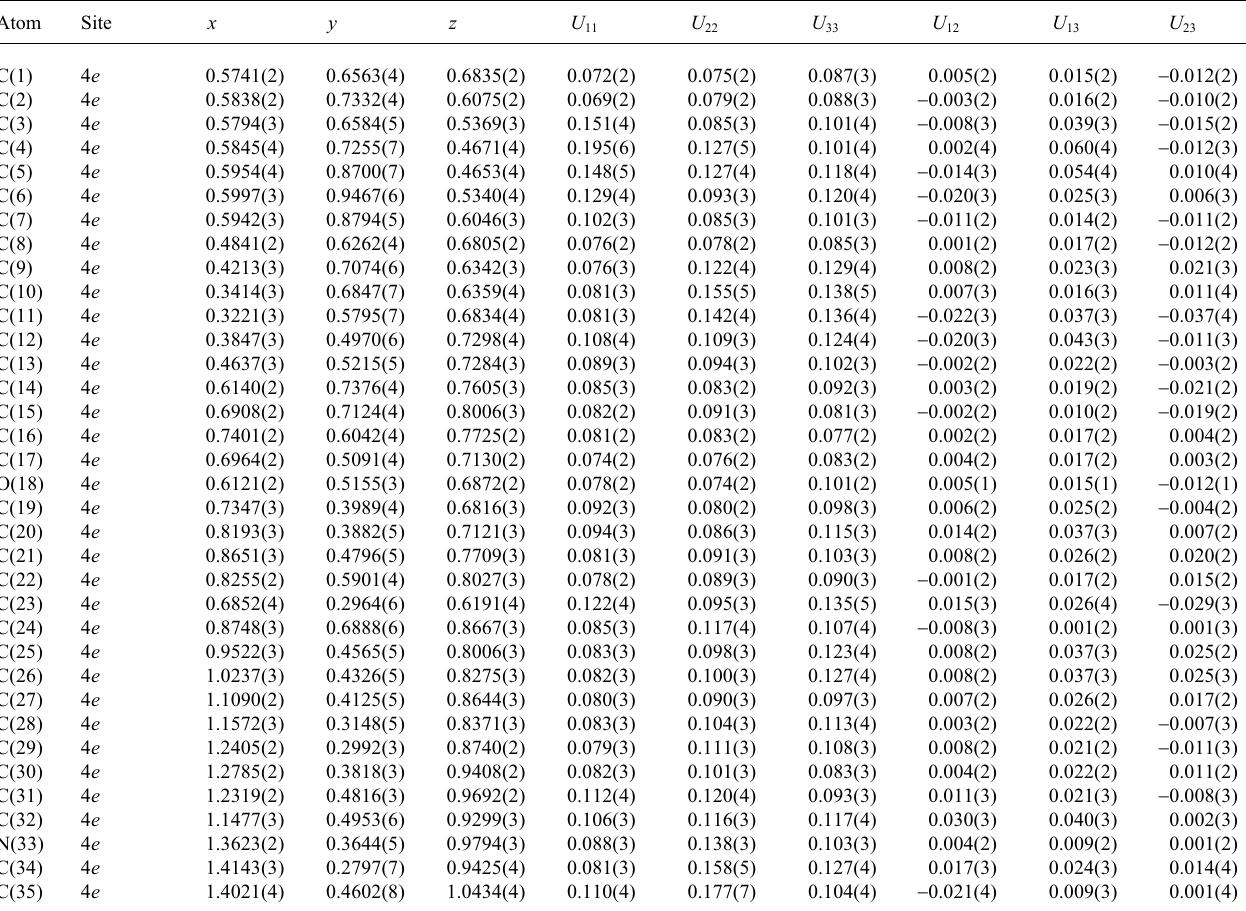
Table 3. Atomic coordinates and displacement parameters (in Å 2 )